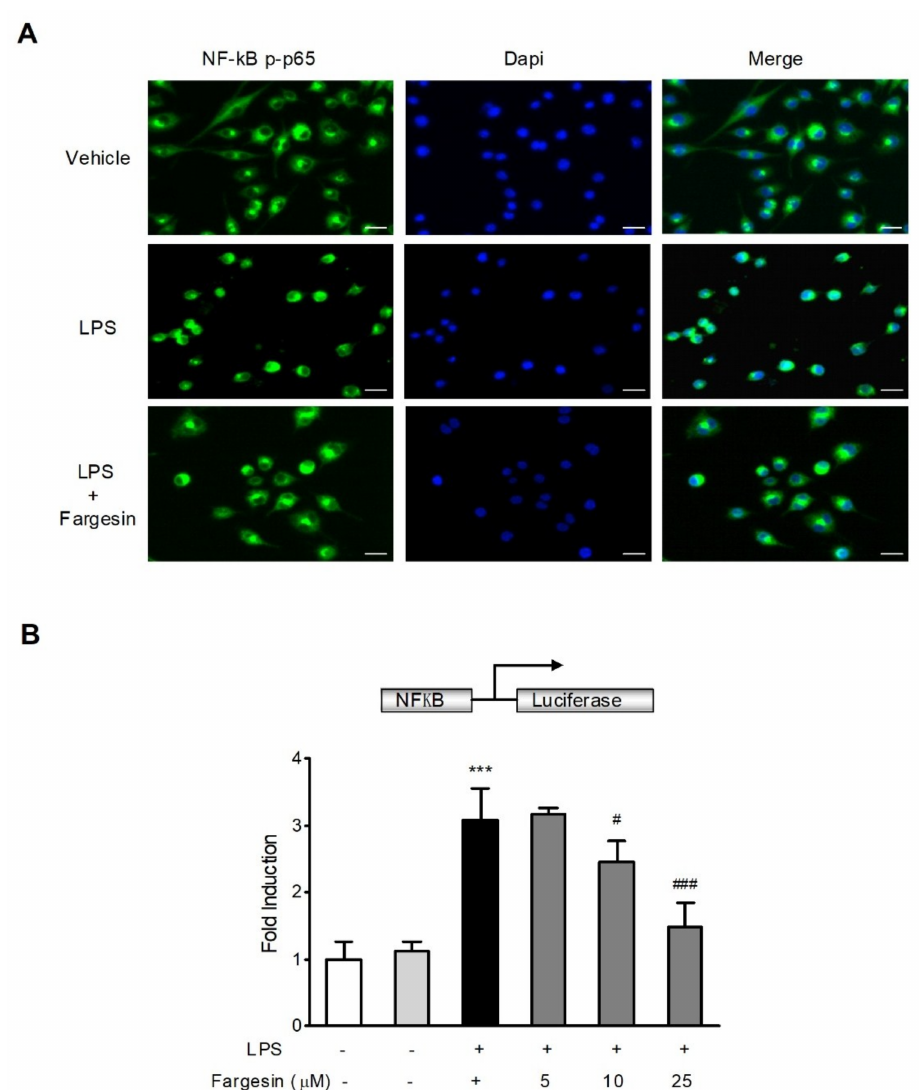
Figure 5. Fargesin blocked the activation of NF- κ B in vitro. ( A ) RAW264.7 cells were treated as described in the Methods and p-p65 localization was visualized under a fluorescence microscope. Scale bar corresponds to 200 µ m. ( B ) RAW264.7 cells were treated as described in the Methods. NF- κ B promoter-driven luciferase activity was determined using a dual luciferase assay system, and values were expressed as the fold induction of the control cells. Data were expressed as mean ± SD of quadruplicates of two independent experiments. *** p < 0.01 vs. vehicle-treated cells; # p < 0.05, ### p < 0.001 vs. LPS-treated